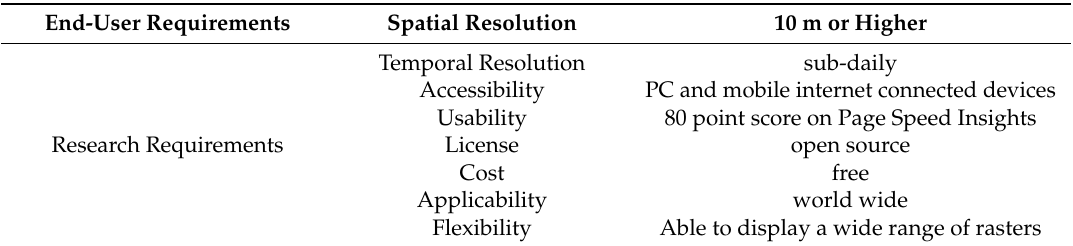
Table 1. Design Requirements of the decision support systems